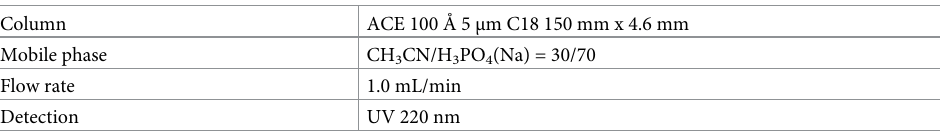
Table 2. High performance liquid chromatography